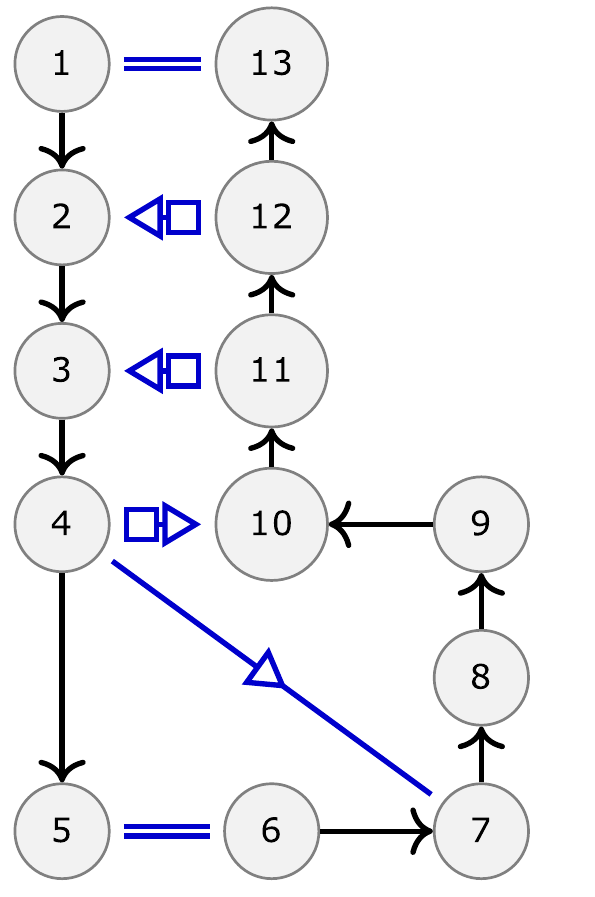
Fig 14. Kink-turn found in Dataset 3.137 with our